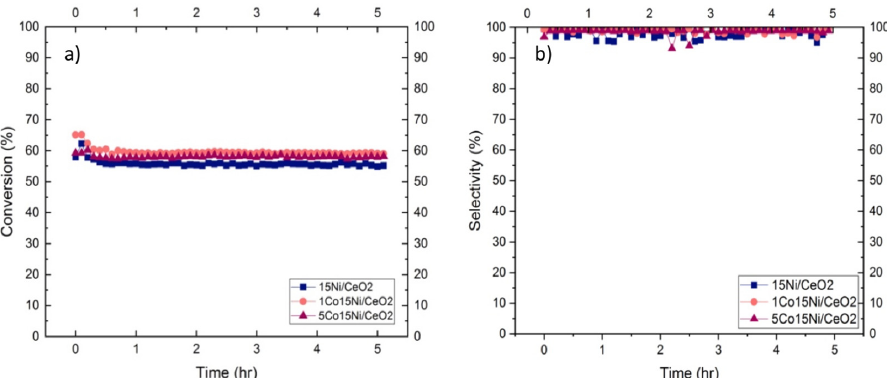
Figure 8. Stability tests: ( a ) CO 2 Conversion and ( b ) CH 4 Selectivity of Co-Ni/CeO 2 catalysts for 5 h run at 250 °C.